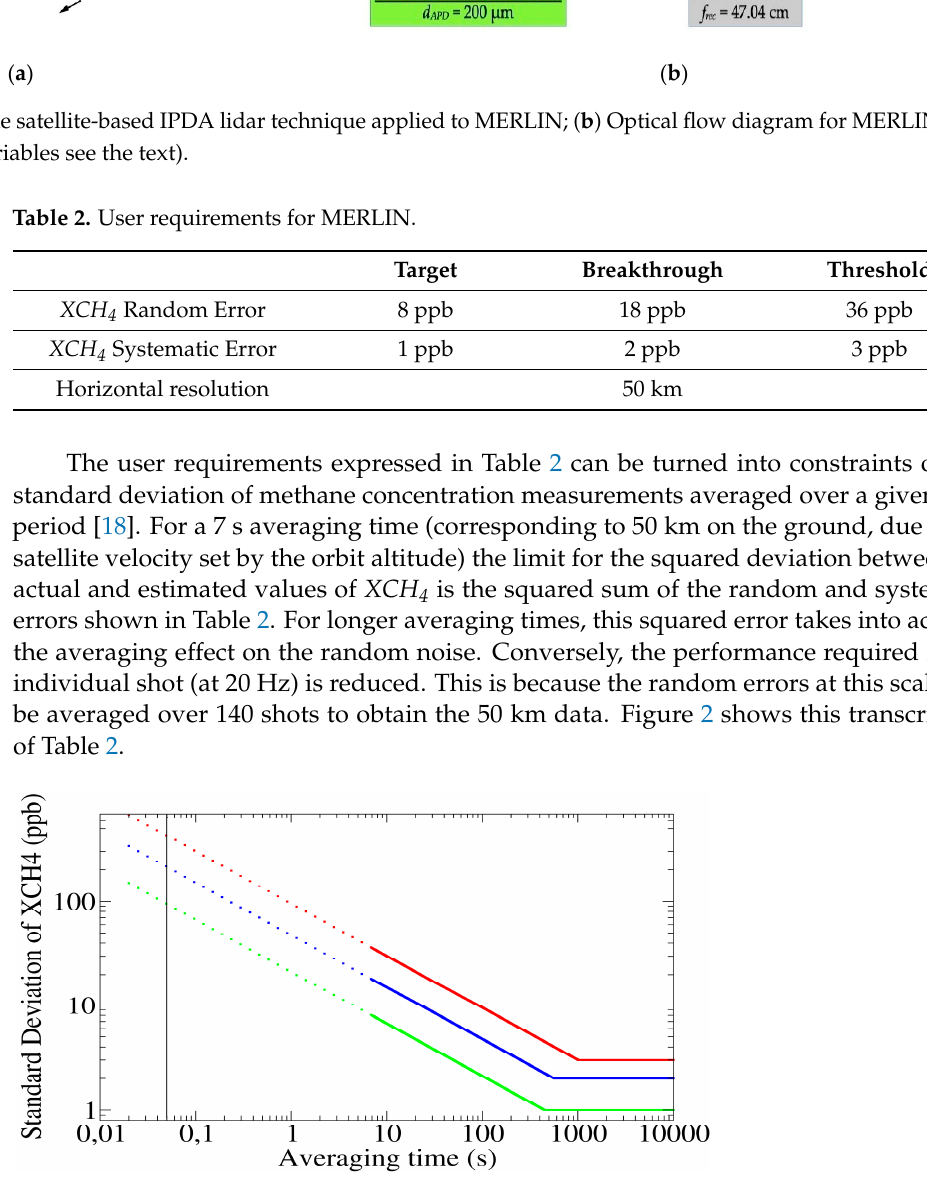
Figure 2. User requirements for the MERLIN mission translated in terms of standard deviation for different averaging times (the red/blue/green curves correspond to the threshold/breakdown/target cases respectively). The vertical black line indicates the performance required for one shot. The lines are continuous from 7 s, the expected averaging time for MRLIN data.